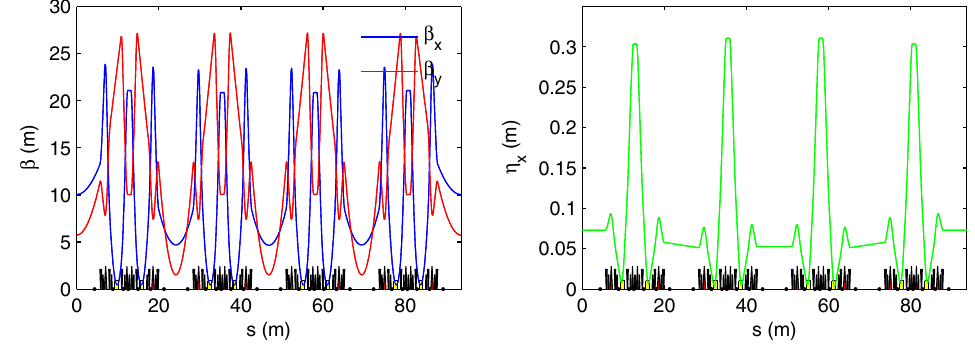
FIG. 1. Linear optics for Diamond in one super period: beta functions (left), dispersion